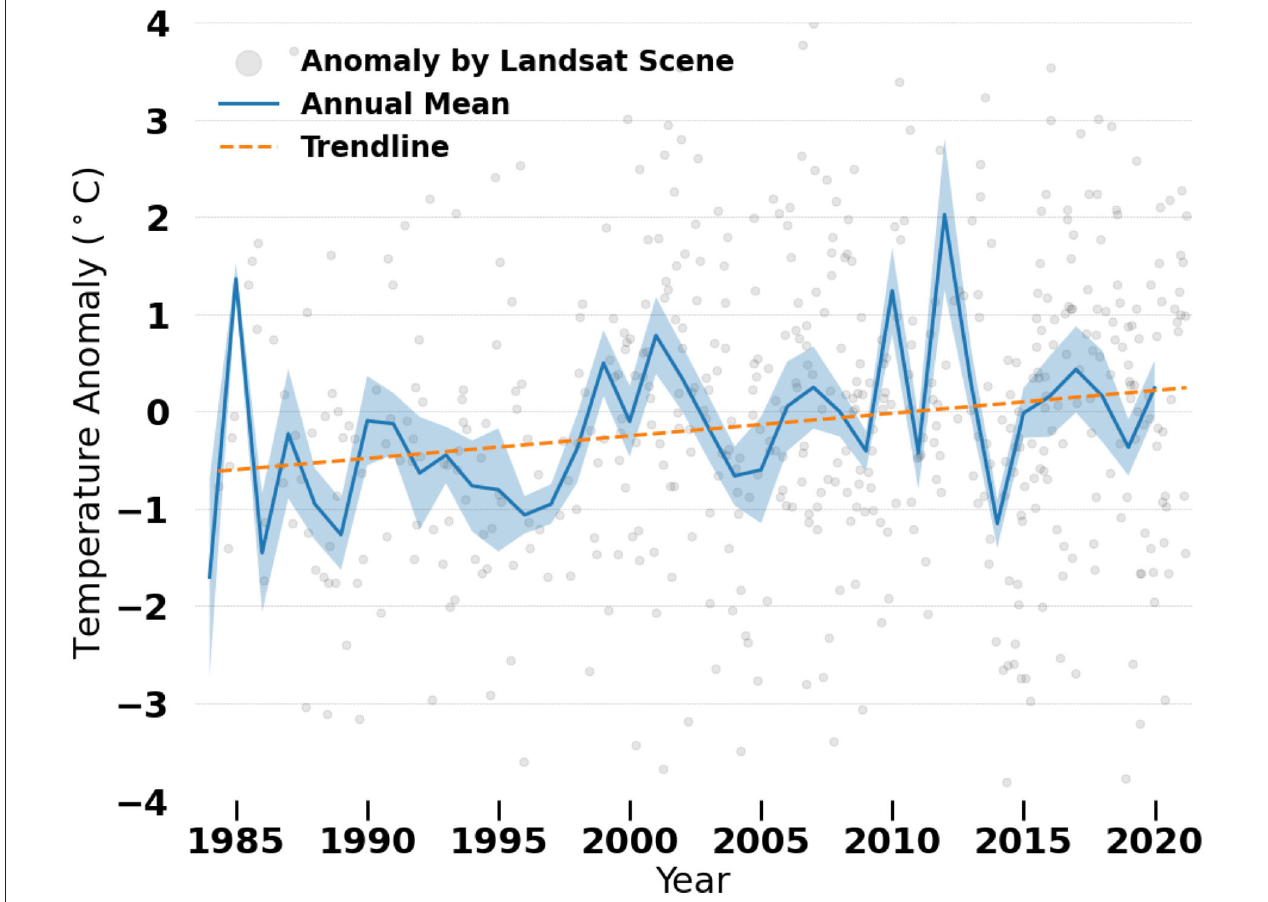
FIGURE 8 | Time series of seasonally-detrended surface temperature anomaly over Narragansett Bay with the annual mean and a linear trendline taken before averaging. The uncertainty around the annual mean represents sampling uncertainty.